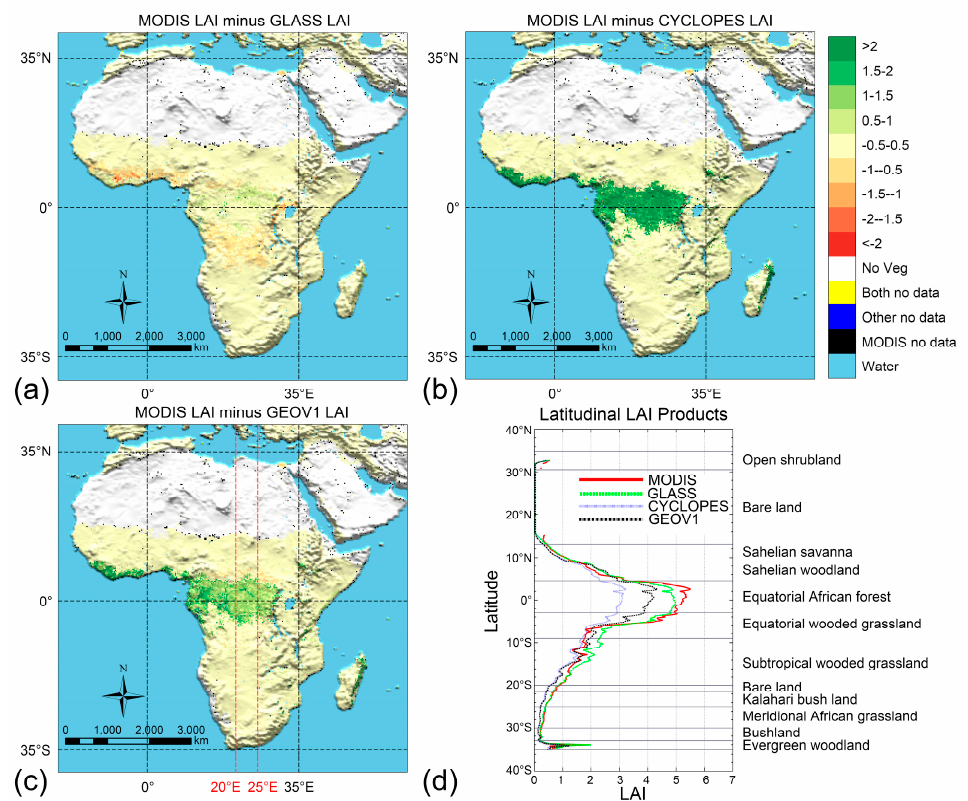
Figure 5. Comparisons of annual averaged LAI from the MODIS, GLASS, CYCLOPES and GEOV1 products over Africa in 2001. ( a – c ) Absolute differences between MODIS C6 and GLASS, CYCLOPES and GEOV1; ( d ) LAI from four products along the transect in Africa between 20° E and 25° E.